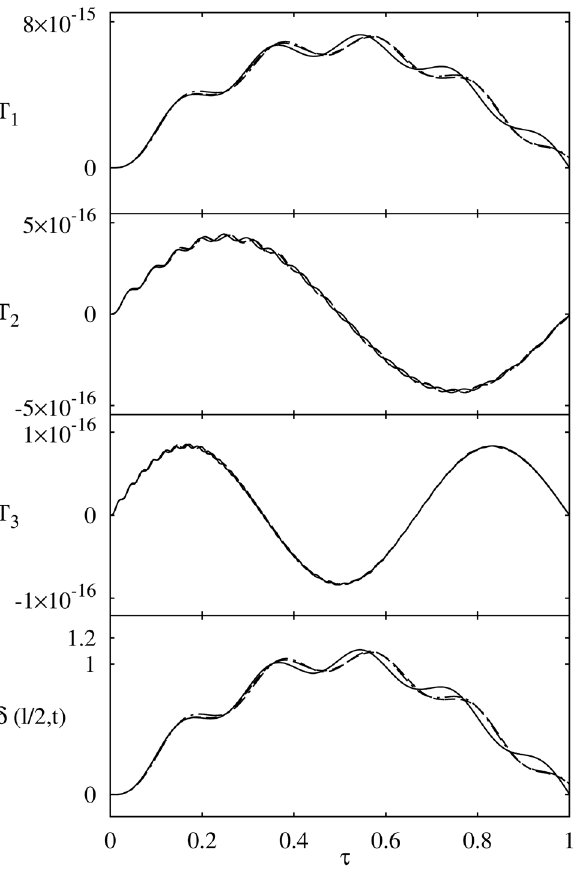
Figure 11 Time functions of the first three natural modes and rela- tive deflections of nanotubes in subresonance, l / d = 10, J = 0, α = 0.5, = 0, µ = 0, γ = 0.01, P / g = m d = 1.621·10 -15 nkg, ____ gravity force; k w i _ . _ gravity and inertia force – harmonic response; _ _ _ gravity and inertia force – parametric